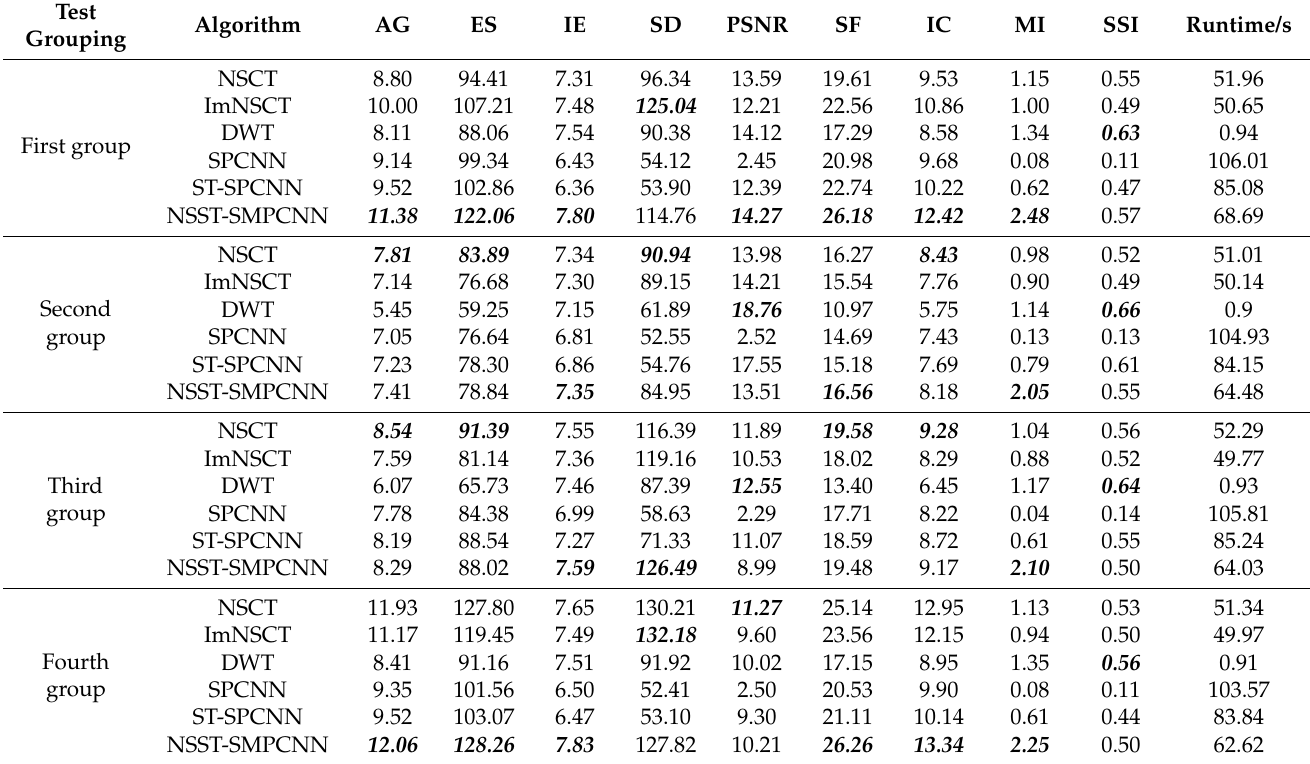
Table 2. Objective evaluation index results of dataset II.